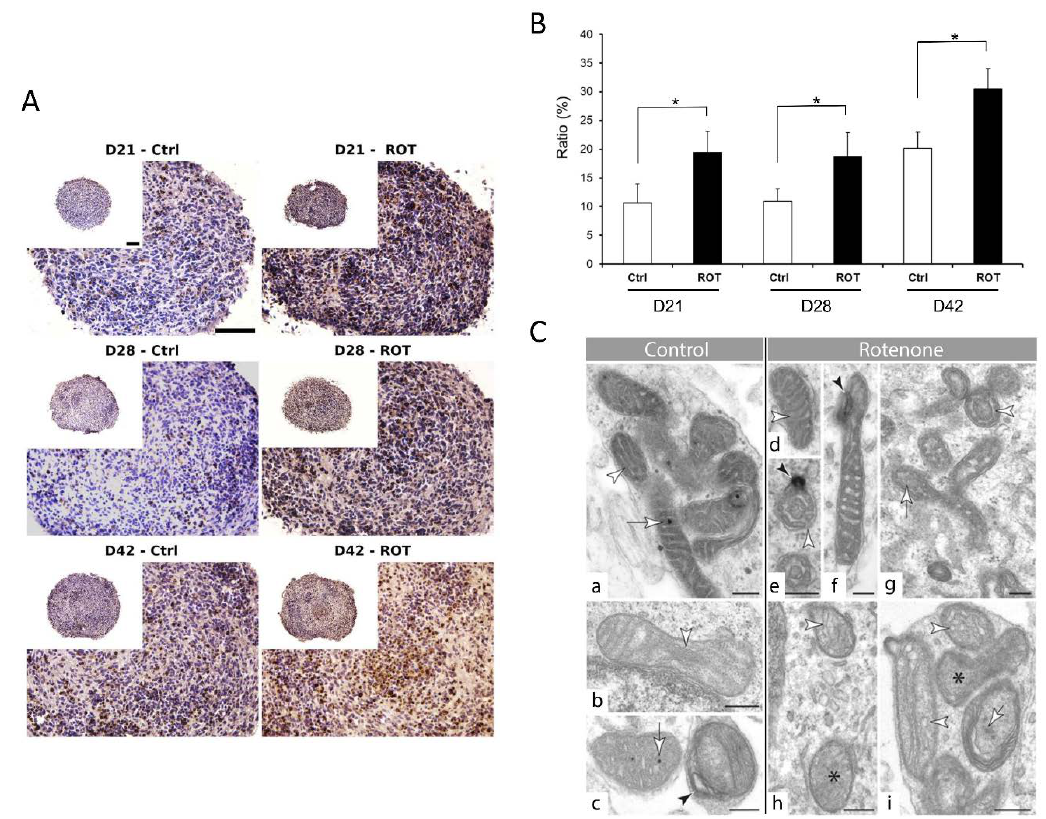
Figure 9. Effect of Rotenone (ROT) exposure on 3D neurospheres at three differentiation stages. ( A ) 3D neurospheres were treated with 0.5 µM ROT concentration for 72 h at three different maturation timepoints (D21, D28, and D42), fixed, sectioned and analyzed to detect the cellular effect of ROT by TUNEL assay (DeadEnd™ Colorimetric TUNEL System, Promega), compared to the vehicle (0.1% DMSO) treated control (scale bar: 100 µm). ( B ) ROT treatment revealed in average a 15% increase in the apoptotic cell number compared to the control in each stage (* p < 0.05). Average values are presented on graphs ( n = 3). ( C ) Ultrastructure of mitochondria in control (panel a, b, c) and ROT treated (d–i) neurons in the 3D spheroids. See the alteration of the internal membrane (cristae) morphology (white arrowheads) in ROT treated cells (d, e, h, i). Black star: unidentifiable cristae morphology in lighter mitochondria (h, i); black arrowhead: membrane swirl in darker organelles (e, f); white arrows: matrix with and without matrix granules (control cells: a, c; treated cells: g, i) Note the density difference between these granules in control (c) and ROT treated mitochondria (panel i) (D21: a, d, f, h; D28: i; D42: b, c, g) (scale bar: 250 nm).